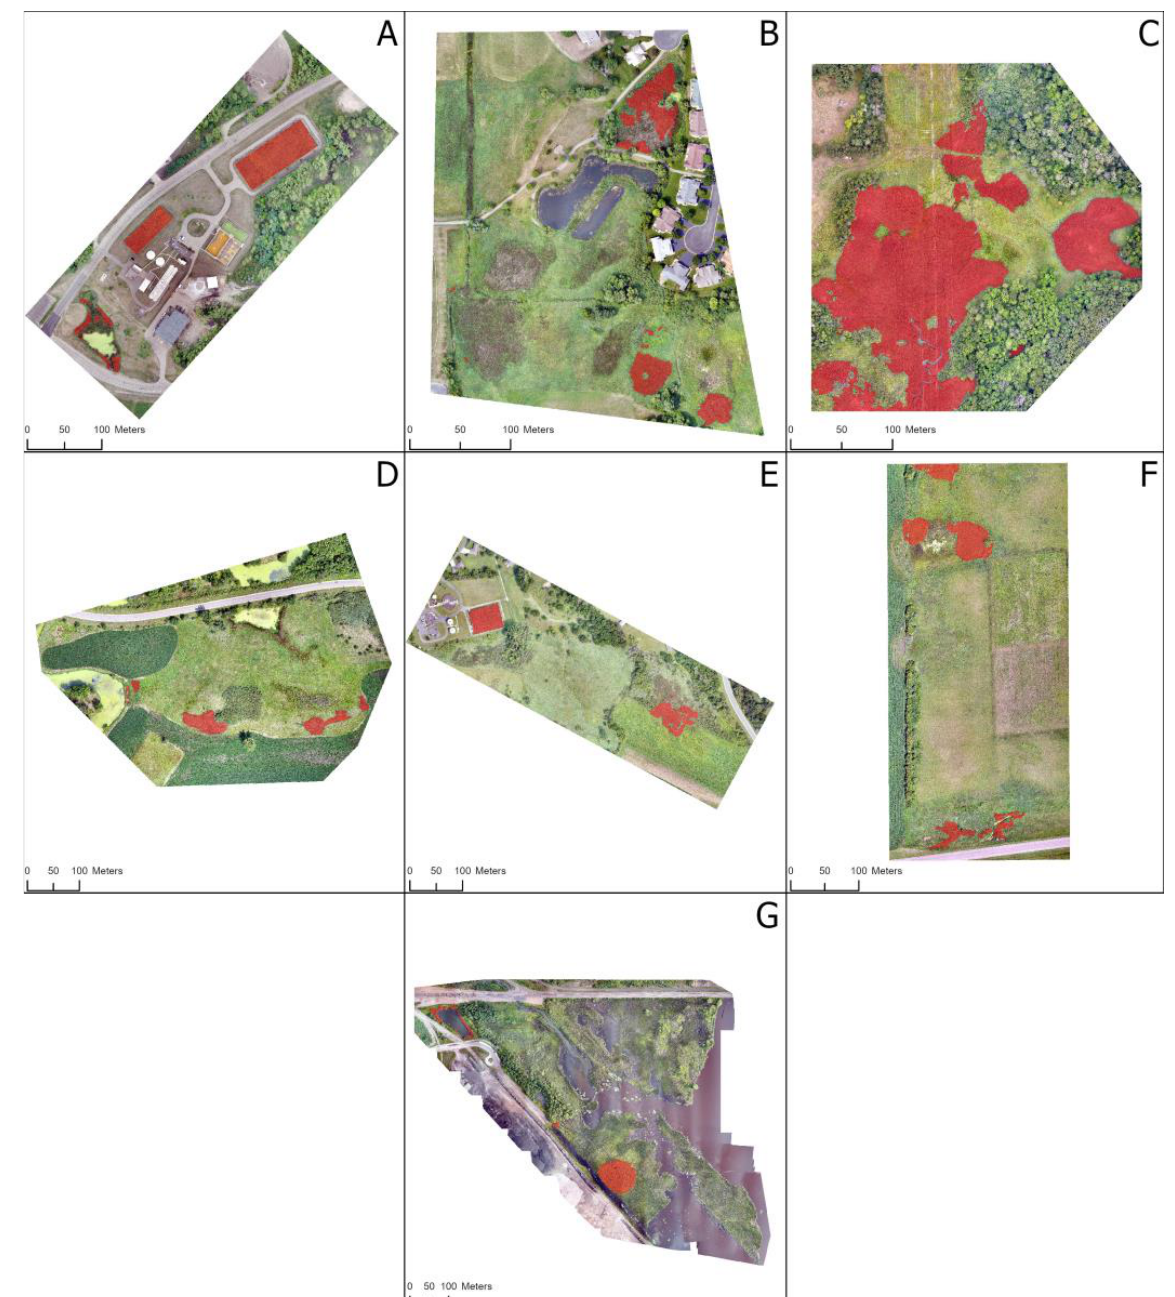
Figure 3. Location of Phragmites in each study area (highlighted in red): ( A ) Delano wastewater treatment facility, ( B ) Delano City Park, ( C ) Chisago City, ( D ) Wabasha, ( E ) Chatfield wastewater treatment facility, ( F ) Swan Lake Wildlife Management Area, and ( G ) Grassy Point Park. The Chatfield WWTF and neighboring land is the fifth study area (Figure 2E). This WWTF is located in Chatfield, Minnesota, which is a small town in southern Minnesota. Land surrounding Chatfield is dominated by agriculture. The WWTF is bordered by Mill Creek and the north branch of the Root River to the east and south. The land directly north of the WWTF is residential housing. A single reed bed planted with invasive Phragmites (Figure 3E) is operated by the city of Chatfield. Seeds from this reed bed have traveled to the neighboring property and established satellite populations. One large patch of Phragmites exists on the eastern side of the site with multiple, smaller patches